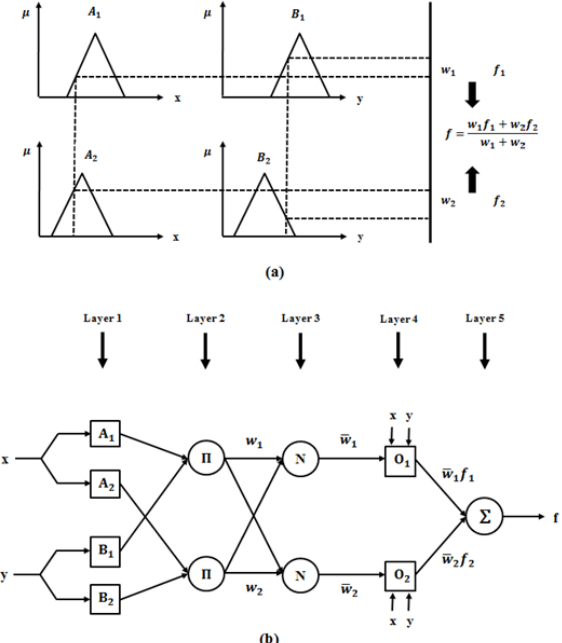
Fig. 1. ANFIS system: (a) first-order T-S model; (b) corresponding